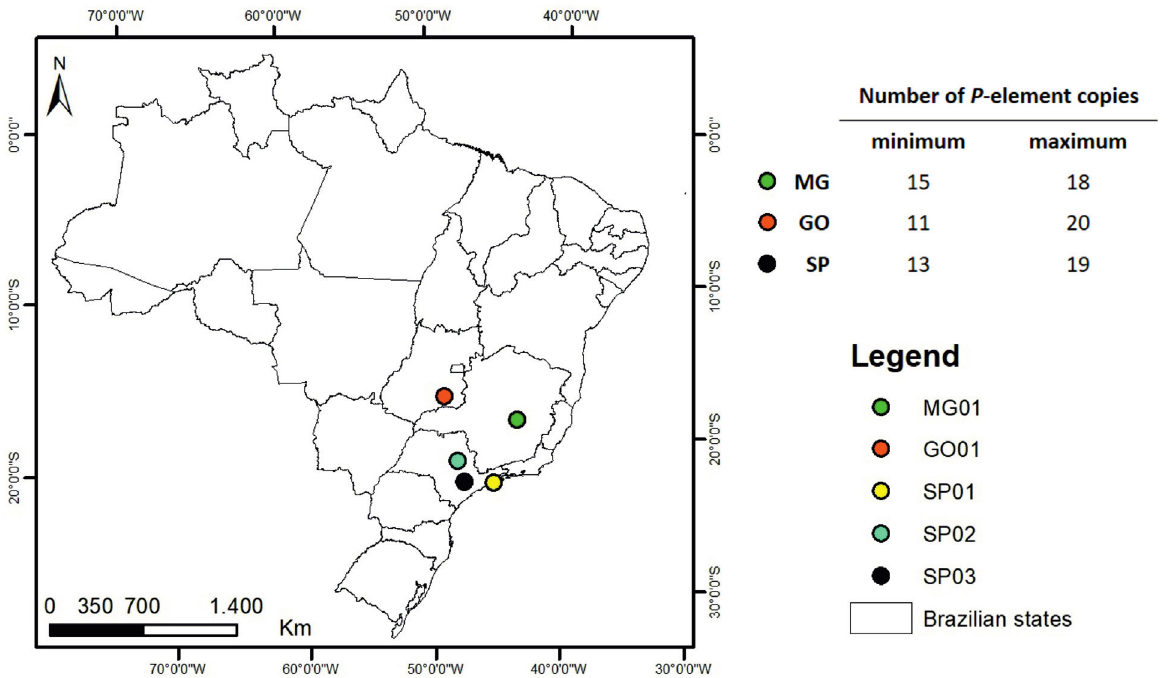
Figure1 -ApproximategeographiclocationsoftheBrazilian D.simulans populationsstudied.Thetableontherightshowsthenumberof P -elementcop- ies estimated for three locations